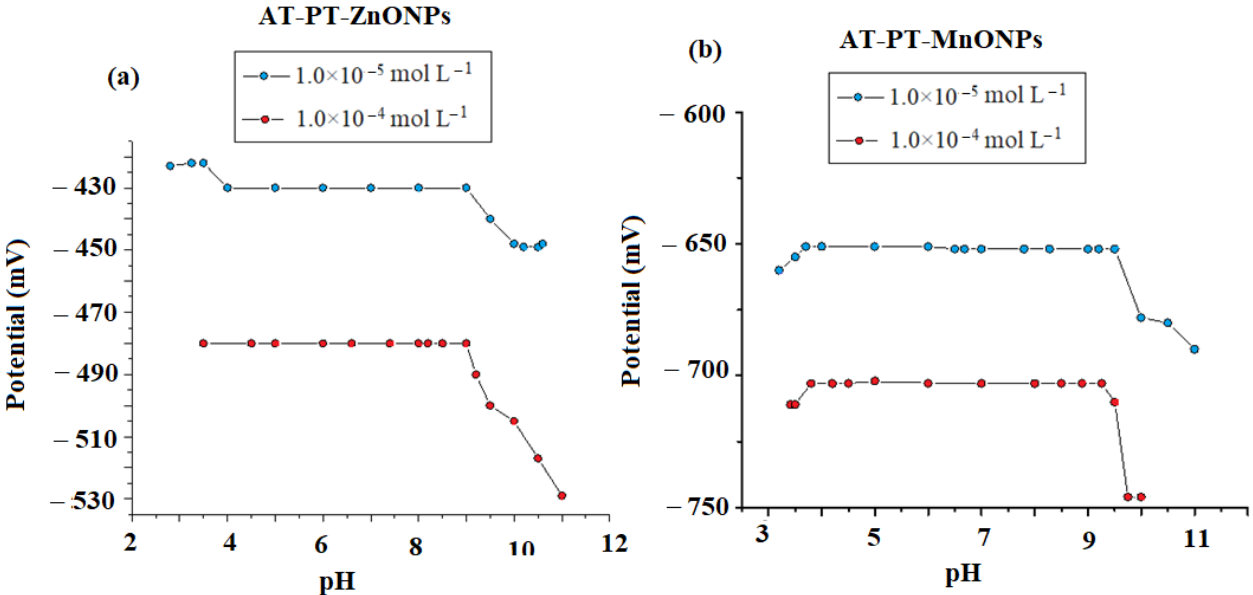
Figure 8. The effect of pH on the investigated ( a ) AT-PT-ZnONP and ( b ) AT-PT-ZnONP sensors using two AT concentrations of 1.0 × 10 −5 and 1.0 × 10 −4 mol L −1 .